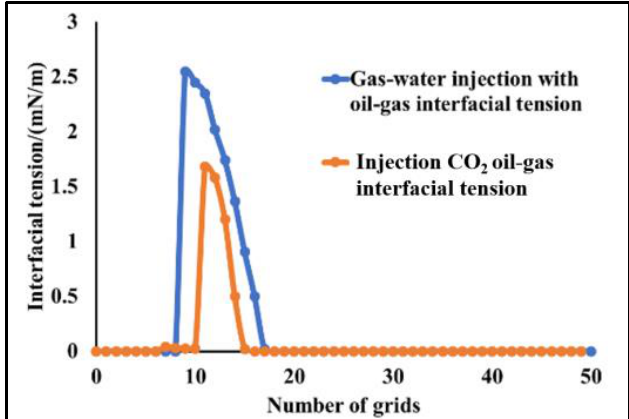
Figure 22. The diagram of oil – gas interfacial tension.